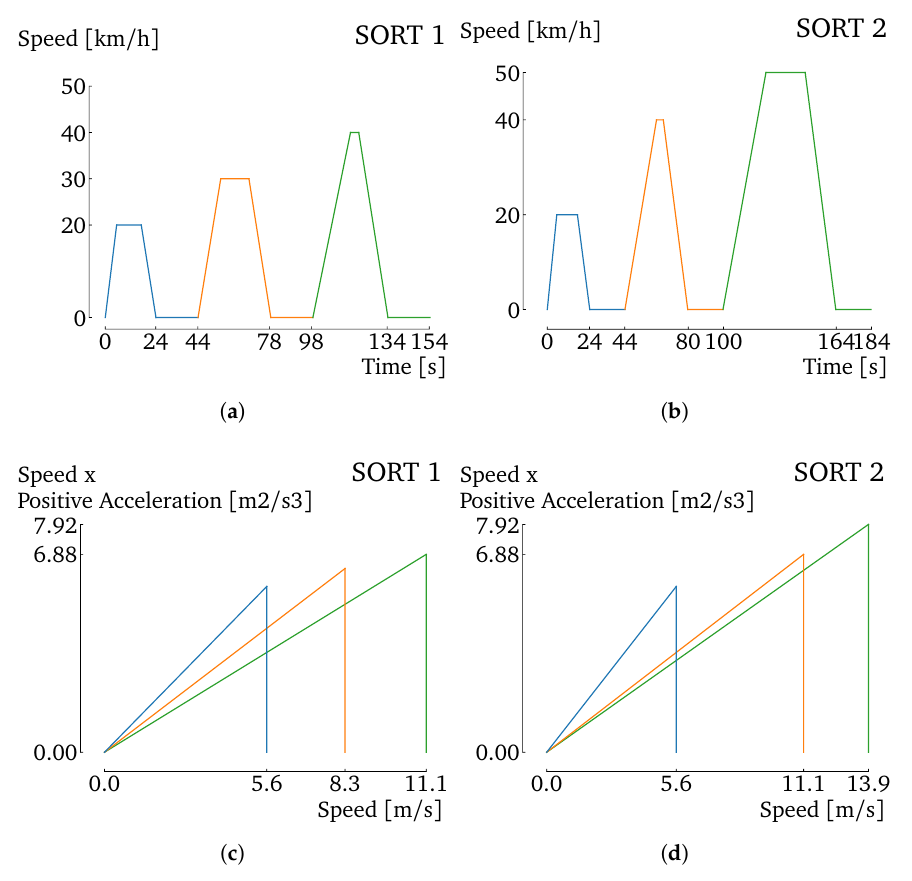
Figure 1. Each SORT base cycle 1 ( a , c ); and 2 ( b , d ) is composed of three trapezoidal speed profiles defined by an acceleration, a section at constant speed, a deceleration, and an idling period. The speed increase is sharper for the first trapezoid than the following